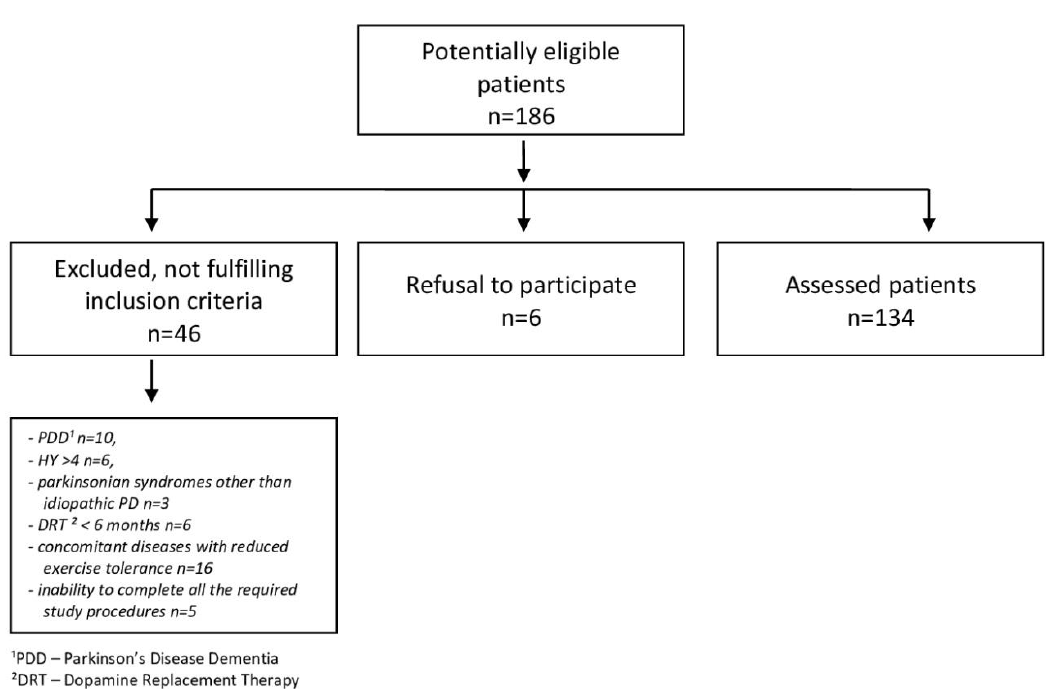
Table 1. Characteristics of the subjects.